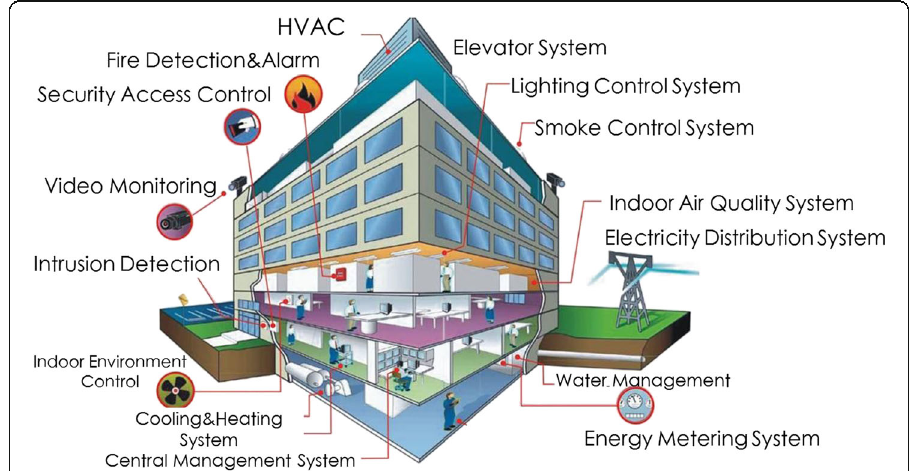
Fig 1. An illustration of related systems in Buildings (Adapted from a source picture on Internet: https://blog.eco